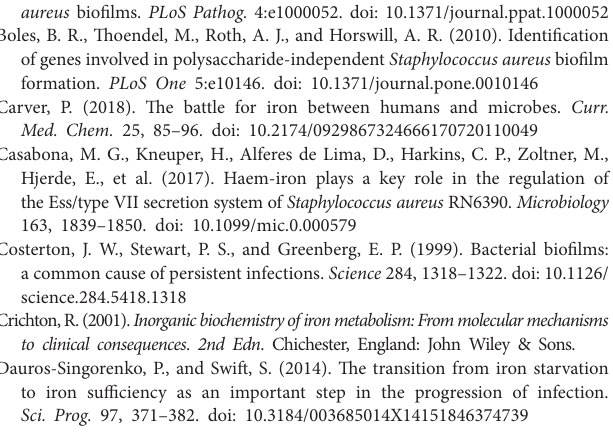
SUPPLEMENTARY TABLE 1 | Strains, plasmids and primers used in this